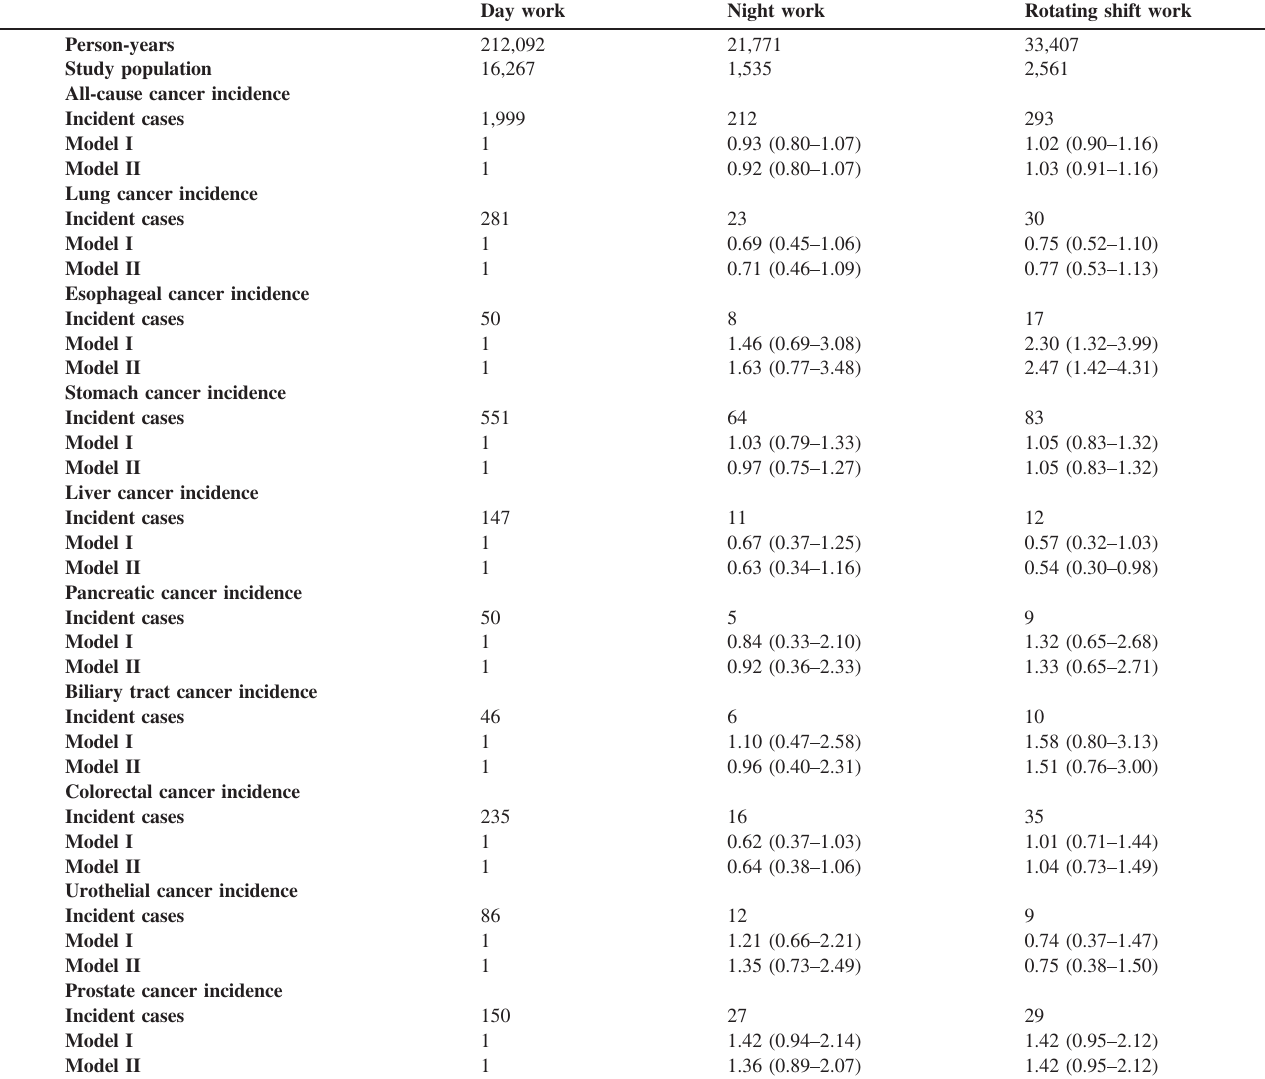
Table 2. Association of night work and rotating shift work with cancer incidence among Japanese men (JACC